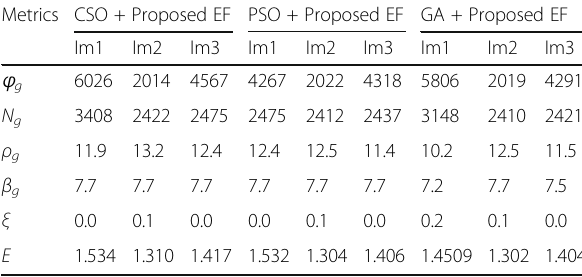
Table 2 Comparison of the different metaheuristic algorithm with our proposed EF based on all the performance evaluation metrics